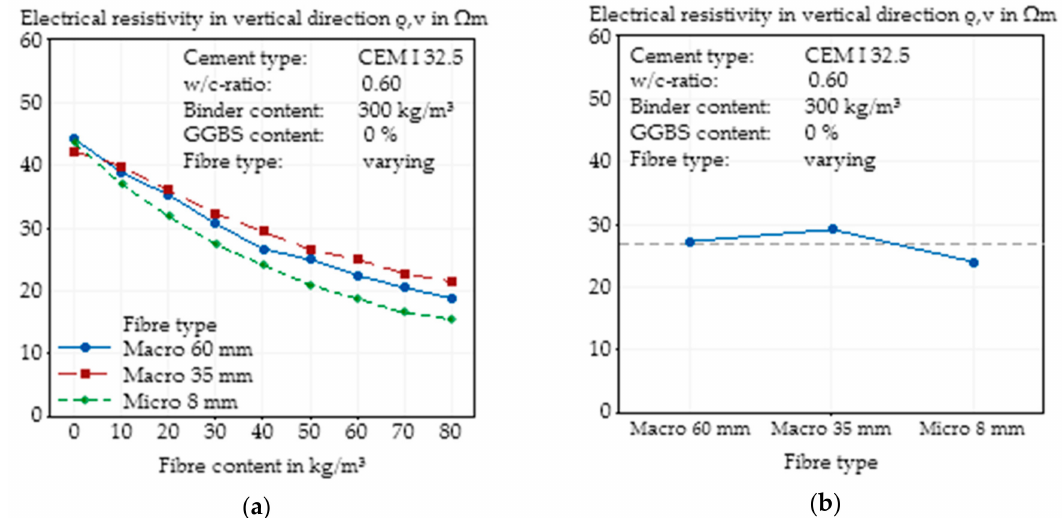
Figure 12. Effect of the steel fibre type (geometry) on the electrical resistivity in vertical direction of SFRC as a function of fibre content ( a ) and main effect plot of the steel fibre type (geometry) on the electrical resistivity in vertical direction of SFRC calculated by Minitab ( b ).